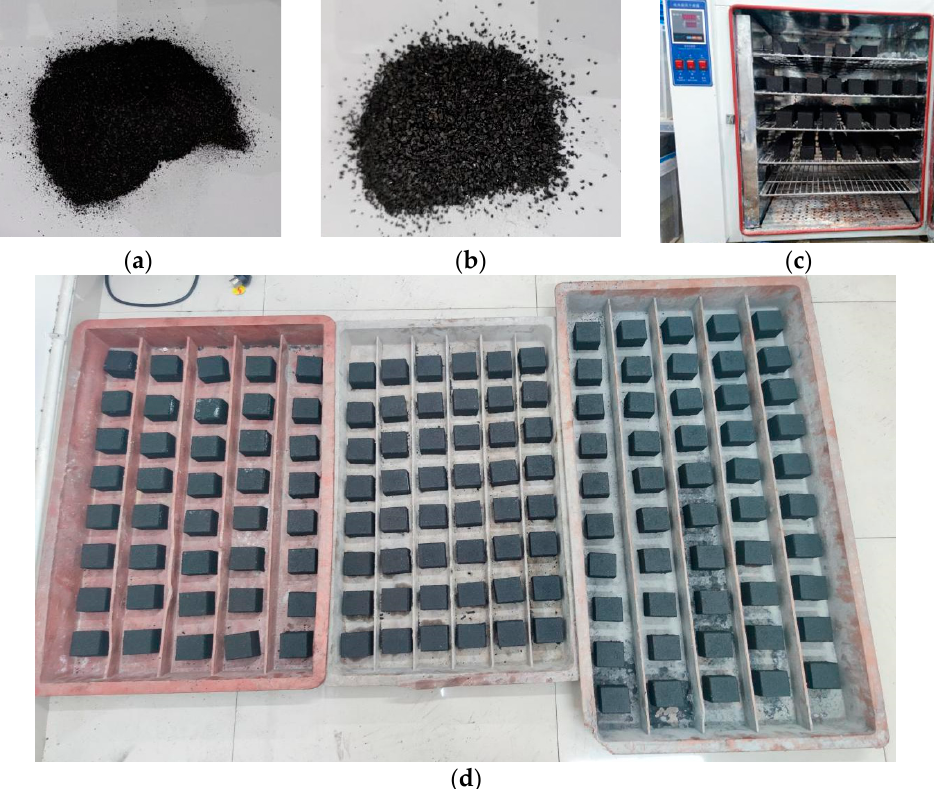
Figure 1. Specimens proportioned using pulverized coal and sodium humate. ( a ) Pulverized coal; ( b ) sodium humate; ( c ) drying oven; ( d ) and coal briquette